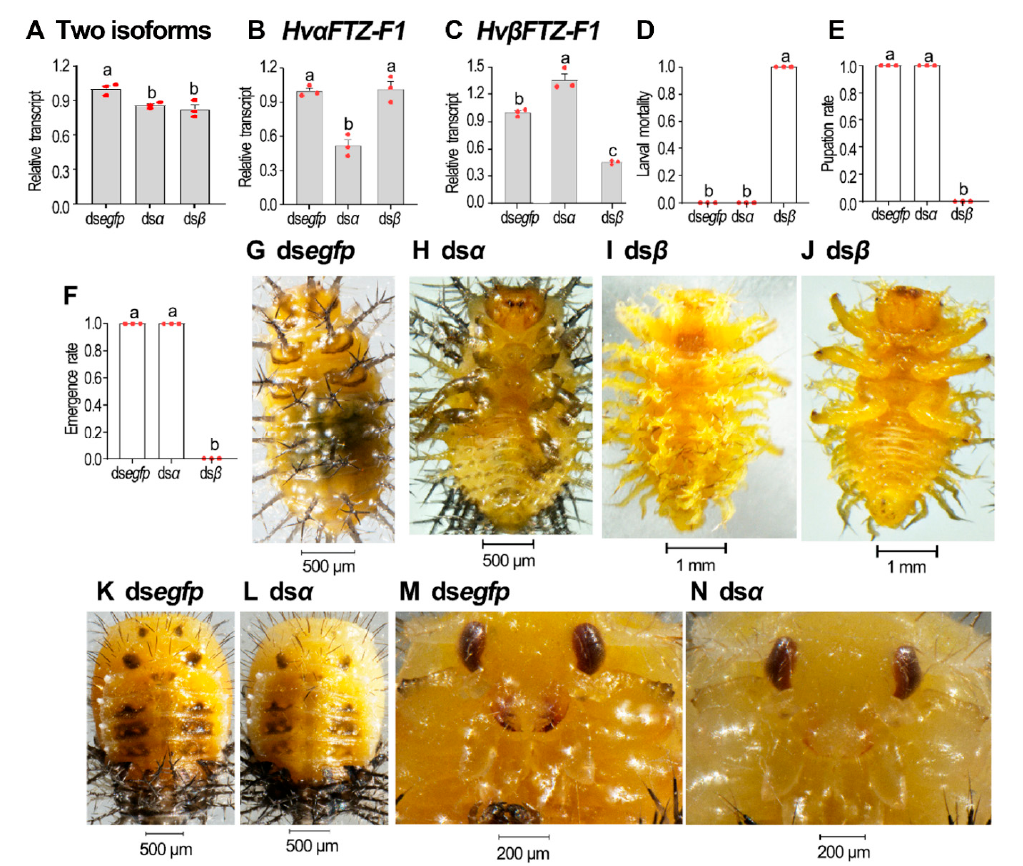
Figure 7. Isoform-specific knockdown of HvFTZ-F1 in third-instar H. vigintioctopunctata larvae. The newly molted third-instar larvae were injected with an aliquot (0.1 µ L) of solution including 300 ng ds egfp , ds α FTZ-F1 or ds β FTZ-F1 . The larvae were then transferred to potato foliage. Three days after injection, transcript levels of two isoforms ( A ), Hv α FTZ-F1 ( B ) and Hv β FTZ-F1 ( C ) were measured. Relative transcripts are the ratios of relative copy number in treated individuals to ds egfp- injected controls, which was set as 1. The larval mortality, pupation and emergence rates were recorded during a 3-week trial period ( D – F ). Three biological replicates were repeatedly marked with red dots. The values represent means ( ± SE). Different letters indicate significant difference at p -value < 0.05 using analysis of variance with the Tukey–Kramer test. Dorsal ( G , I , K , L ) and ventral ( H , J ) views of resultant beetles are shown. The pupal heads of ds egfp - and ds α FTZ-F1 -treated ladybirds were further amplified ( M , N